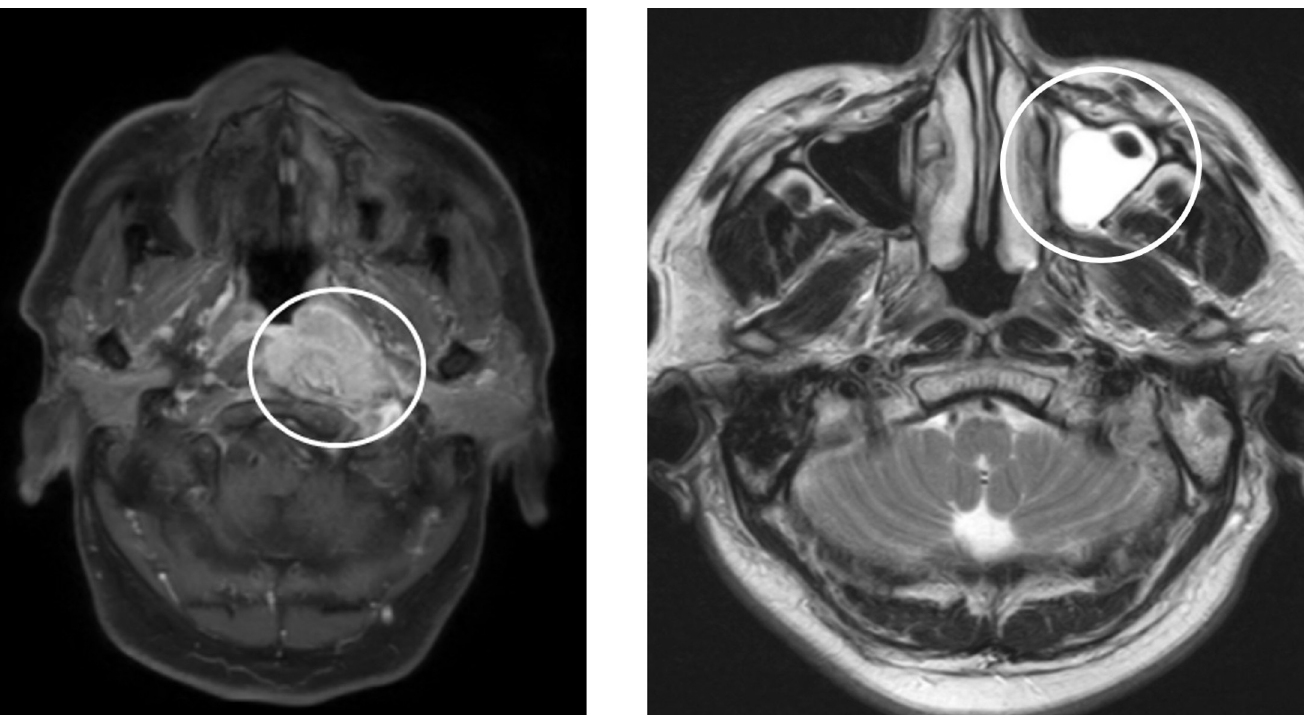
PLOS ONE | https://doi.org/10.1371/journal.pone.0274263 September 9,